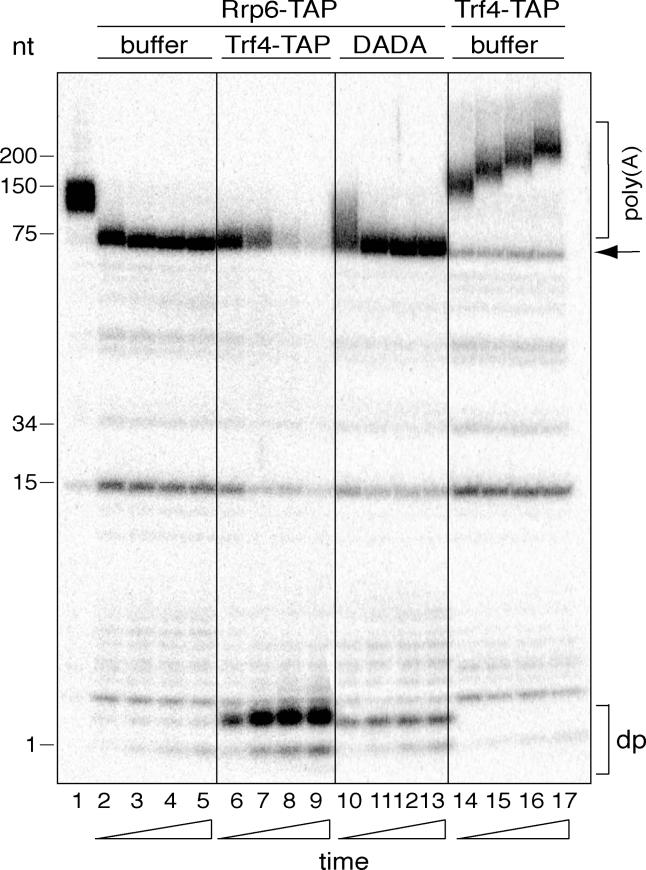
Efficient Degradation of tRNAi
Met May Involve Multiple Rounds of Deadenylation and ReadenylationUncoupled exosome assay on pre-adenylated tRNA. 5′-end-labeled and in vitro polyadenylated unmodified tRNAi
Met was incubated with 50 ng of affinity-purified Rrp6-TAP eluate alone or in combination with 50 ng of wild-type (Trf4-TAP) or mutant (DADA) complex or 50 ng of Trf4-TAP alone. Reactions were stopped after 30 (lanes 2, 6, 10, and 14), 60 (lanes 3, 7, 11, and 15), 90 (lanes 4, 8, 12, and 16), or 120 min (lanes 5, 9, 13, and 17) and separated on a 15% gel. The arrow indicates the position of the nonadenylated tRNA. Protein was omitted in lane 1. The migration positions of the polyadenylated tRNA (poly[A]) and the degradation products (dp) are indicated by brackets.